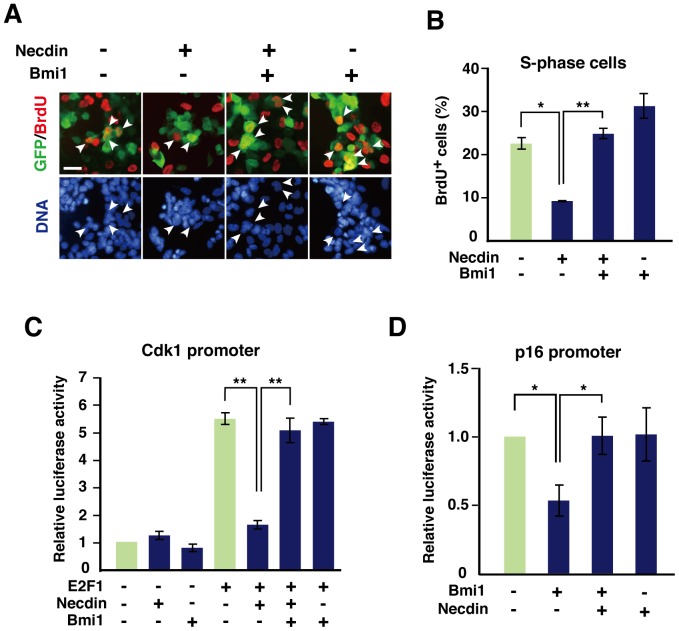
Necdin and Bmi1 relieve transcriptional suppression of the p16 and Cdk1 promoters.(A, B) BrdU incorporation assay. HEK293A cells transfected with expression vectors for GFP, necdin, and Bmi1 were immunostained for GFP (green) and BrdU (red) (A). BrdU+ cells among 500 GFP-expressing cells were counted (n = 3) (B). Arrowheads point to GFP+/BrdU+ cells. Scale bar, 10 µm. (C, D): Promoter assay. Luciferase reporter vectors containing the Cdk1 (C) and p16 (D) promoters and expression vectors for E2F1, necdin, and Myc-tagged full-length Bmi1 (Bmi1) were co-transfected into HEK293A cells. Promoter activities were measured with a luminometer. Values in (B−D) represent the mean ± SEM, n = 3. *p<0.05, **p<0.01.